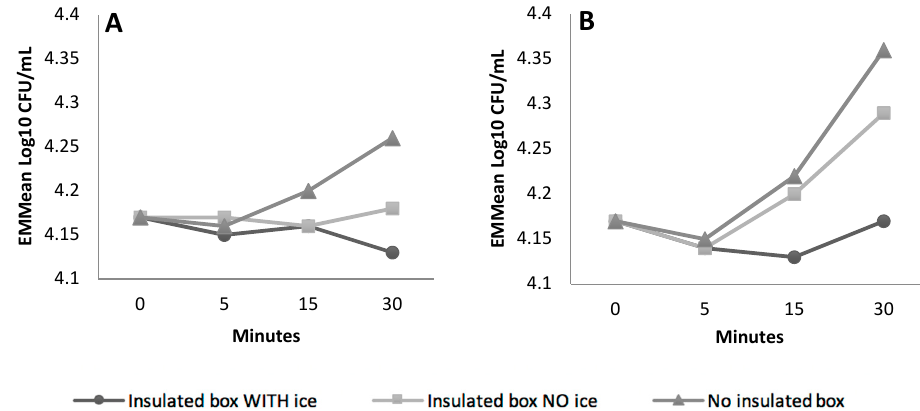
Figure 2. EMMeans of E. coli O157:H7 ( A ) and L. monocytogenes ( B ) concentrations under various storage types over 30 min, statistically controlling for shaker incubation temperature and pathogen inoculum level factors.